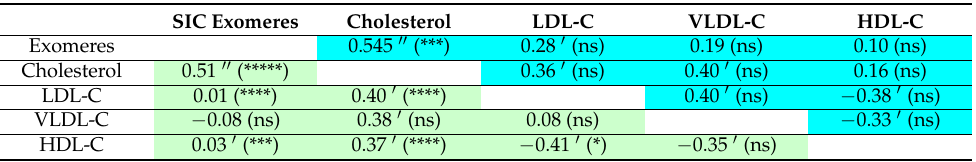
Table 3. Pearson correlation and partial correlation coefficients of lipid profile parameters and SIC exomeres in the group “After